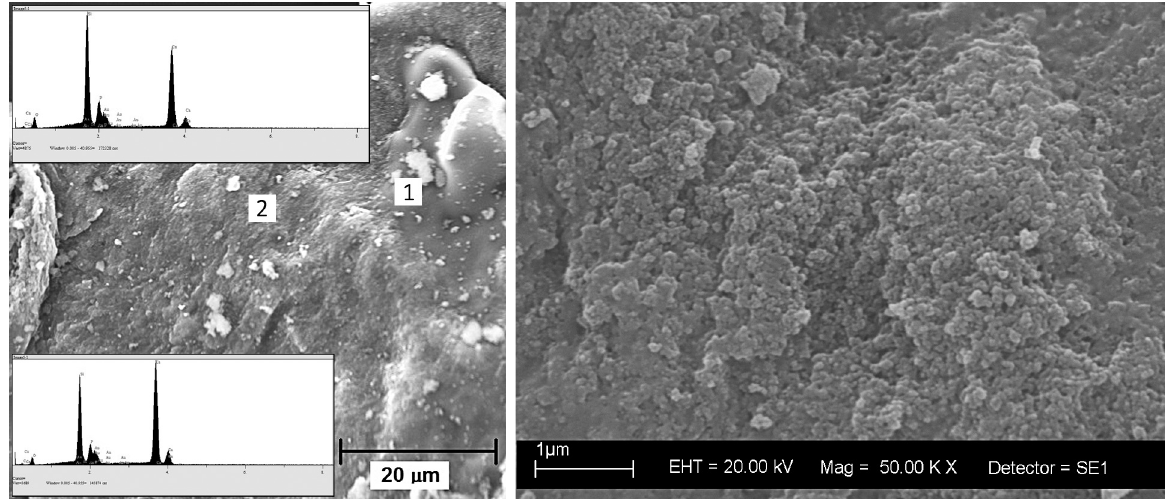
Figure 8 - SEM micrographs for HAS treated at